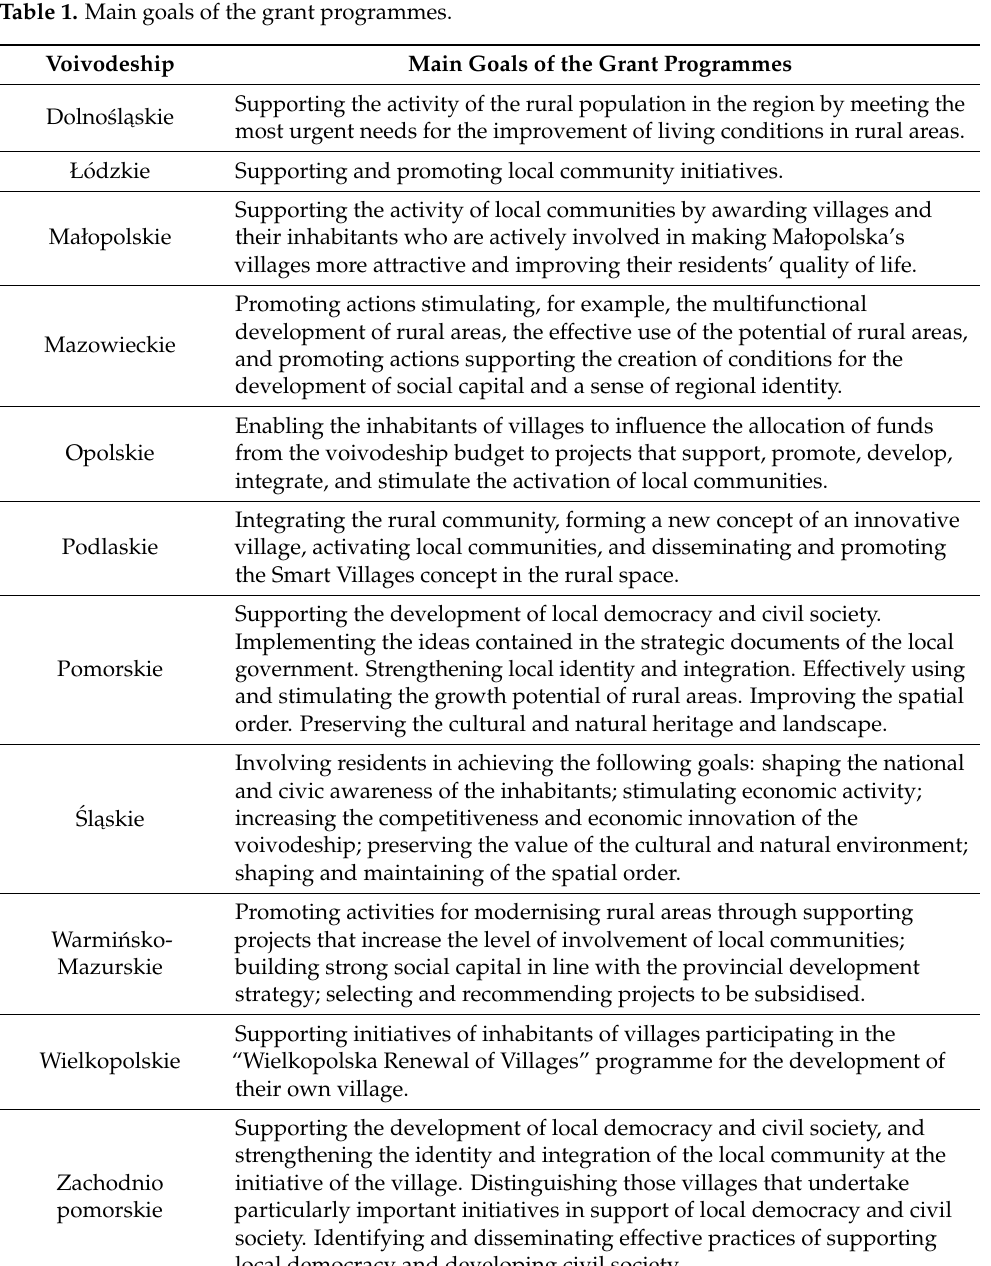
Table 1. Main goals of the grant